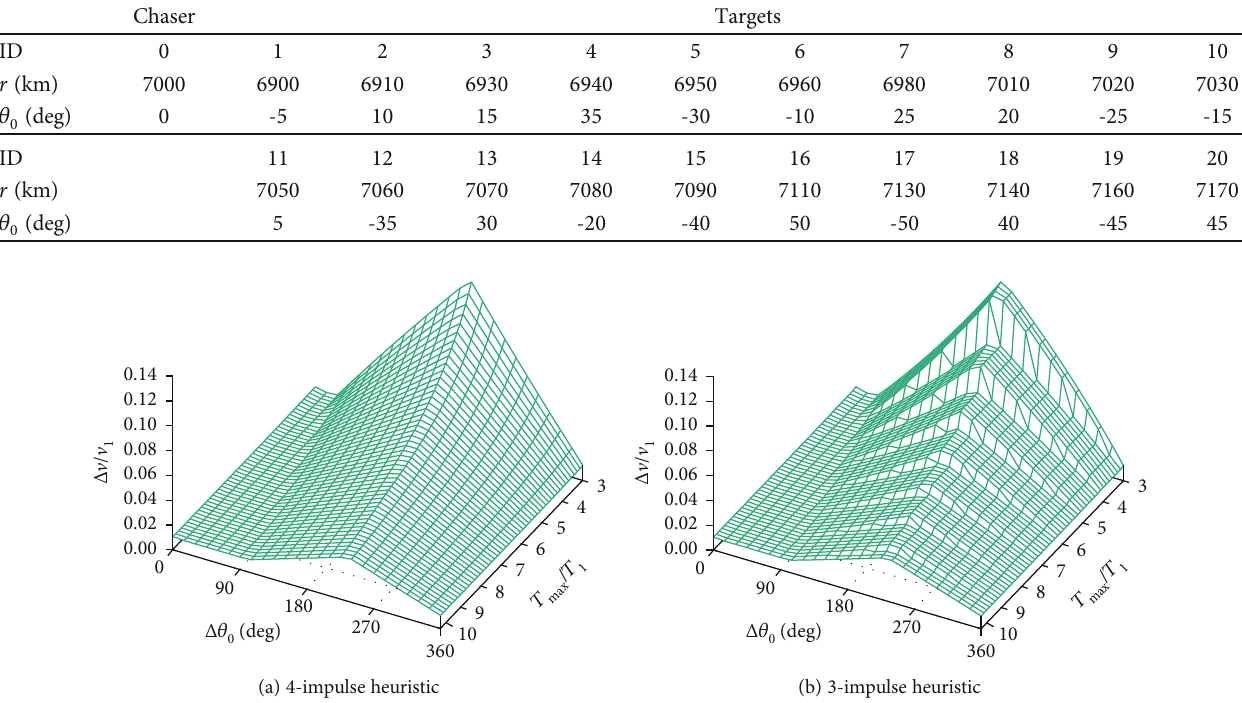
∈ ½ 0, 2 π (cid:2) and transfer time T 0